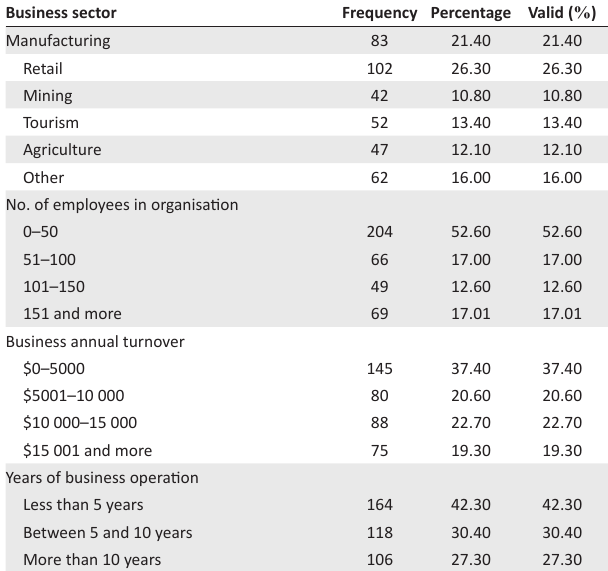
TABLE 1: General characteristics of participants ( N =